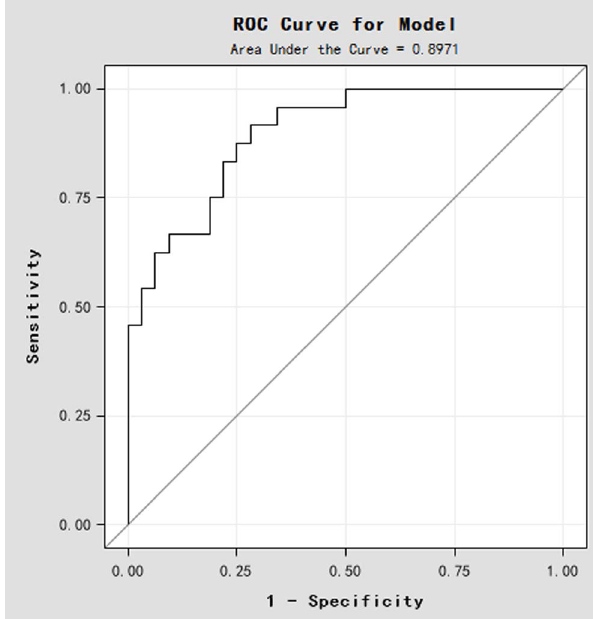
Figure 3. The predictive value of miR-19a and miR-205 expression regarding luminal A breast cancer patients’ treat- ment responses. A ROC curve analysis for miR-19a and miR-205 expression was performed to assess the luminal A breast cancer treatment response.